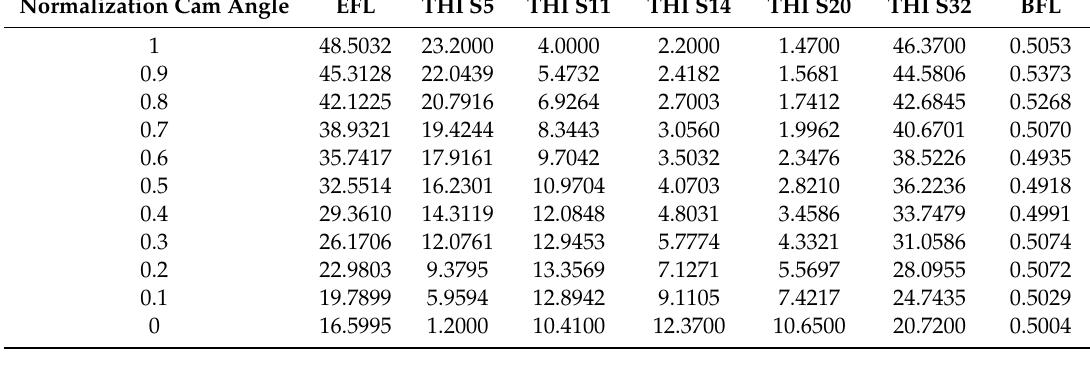
Table 5. Linearization of EFL using the Pad é approximation.